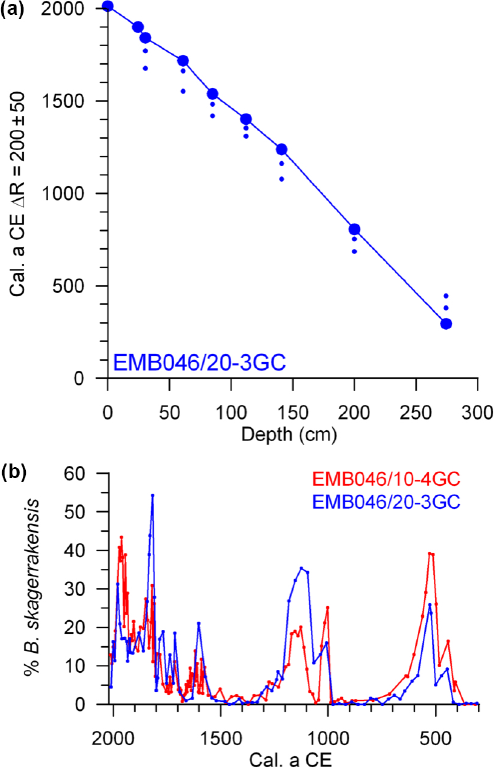
Figure 2. (a) Linear interpolation between the established tie points for the EMB046/20-3GC age model. (b) The relationship between B. skagerrakensis of EMB046/10-4GC (red curve) and EMB046/20-3GC (blue